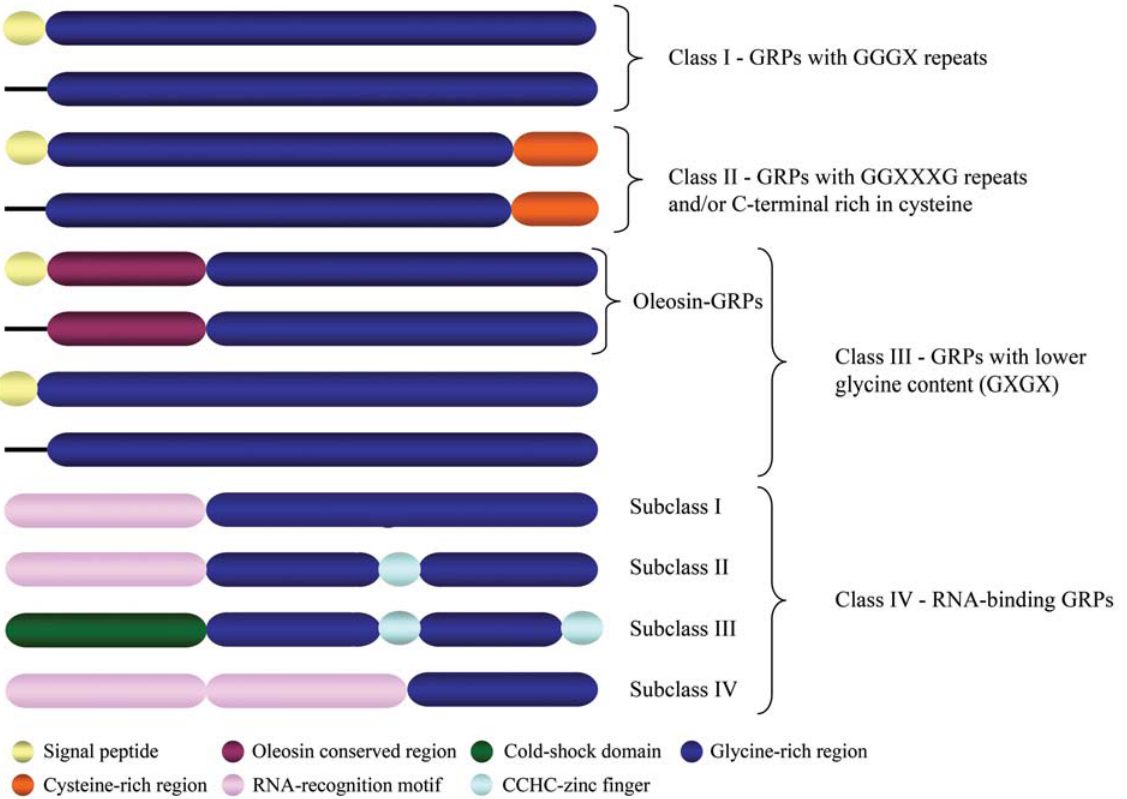
Figure 1 - Schematic representation of the domain organization of plant glycine-rich proteins